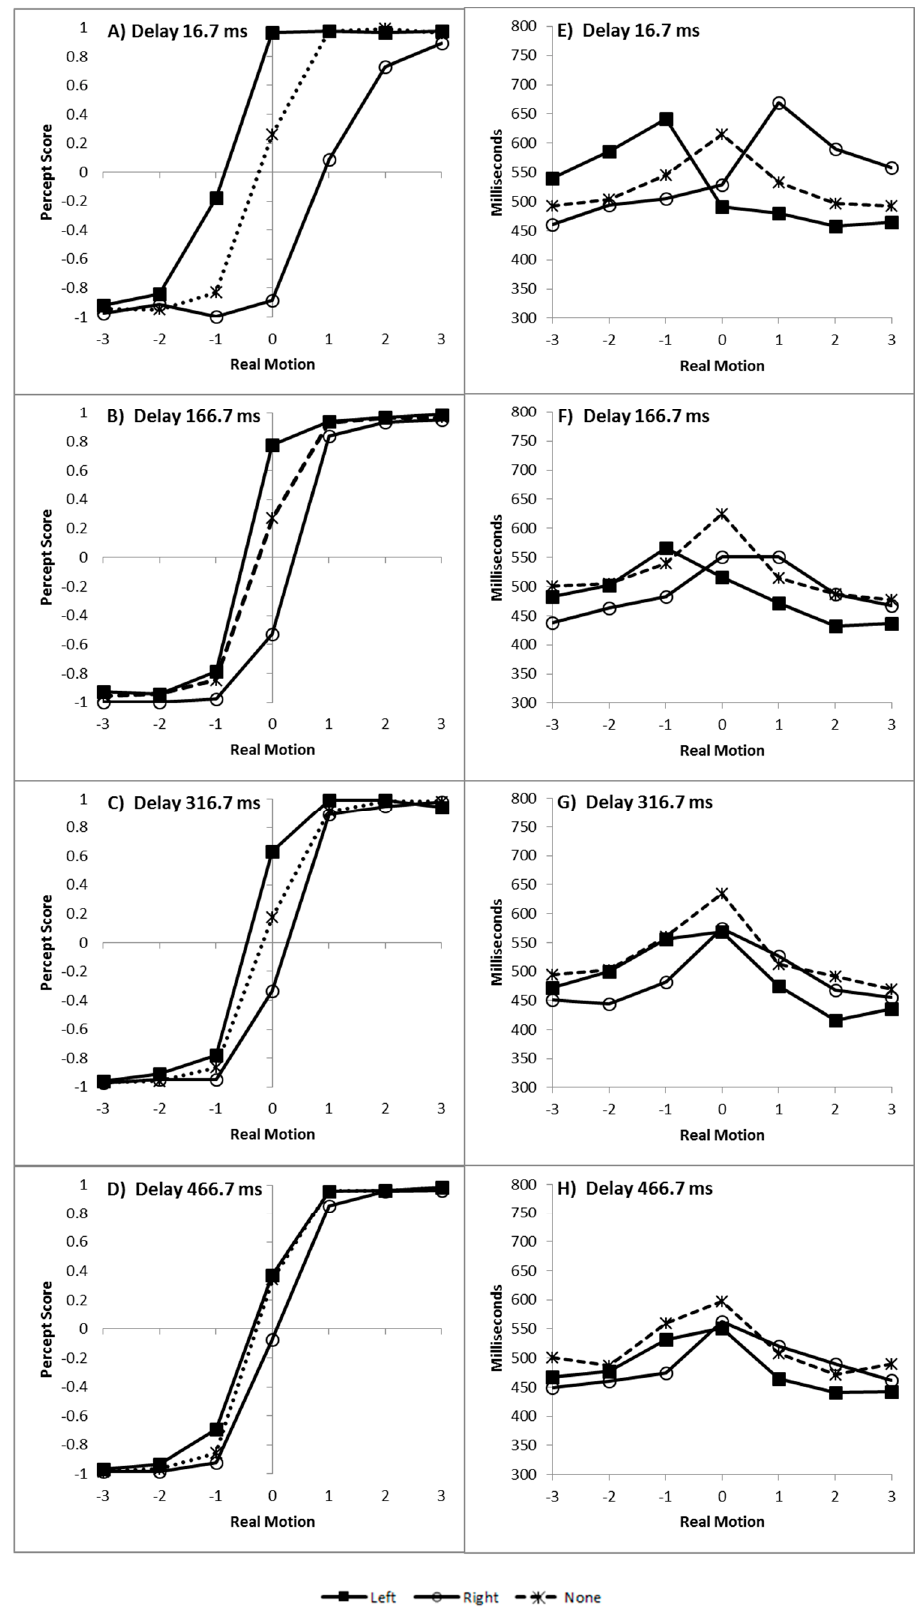
Figure 2. Mean perception scores ( A – D ) and decision times ( E – H ) from Experiment 1 for left (solid lines with filled squares), right (solid lines with open circles), and no flash conditions (dashed lines with asterisks) for cue-bar ISIs of 16.7 ms (A and E), 166.7 ms (B and F), 316.7 ms (C and G), and 466.7 ms (D and H).